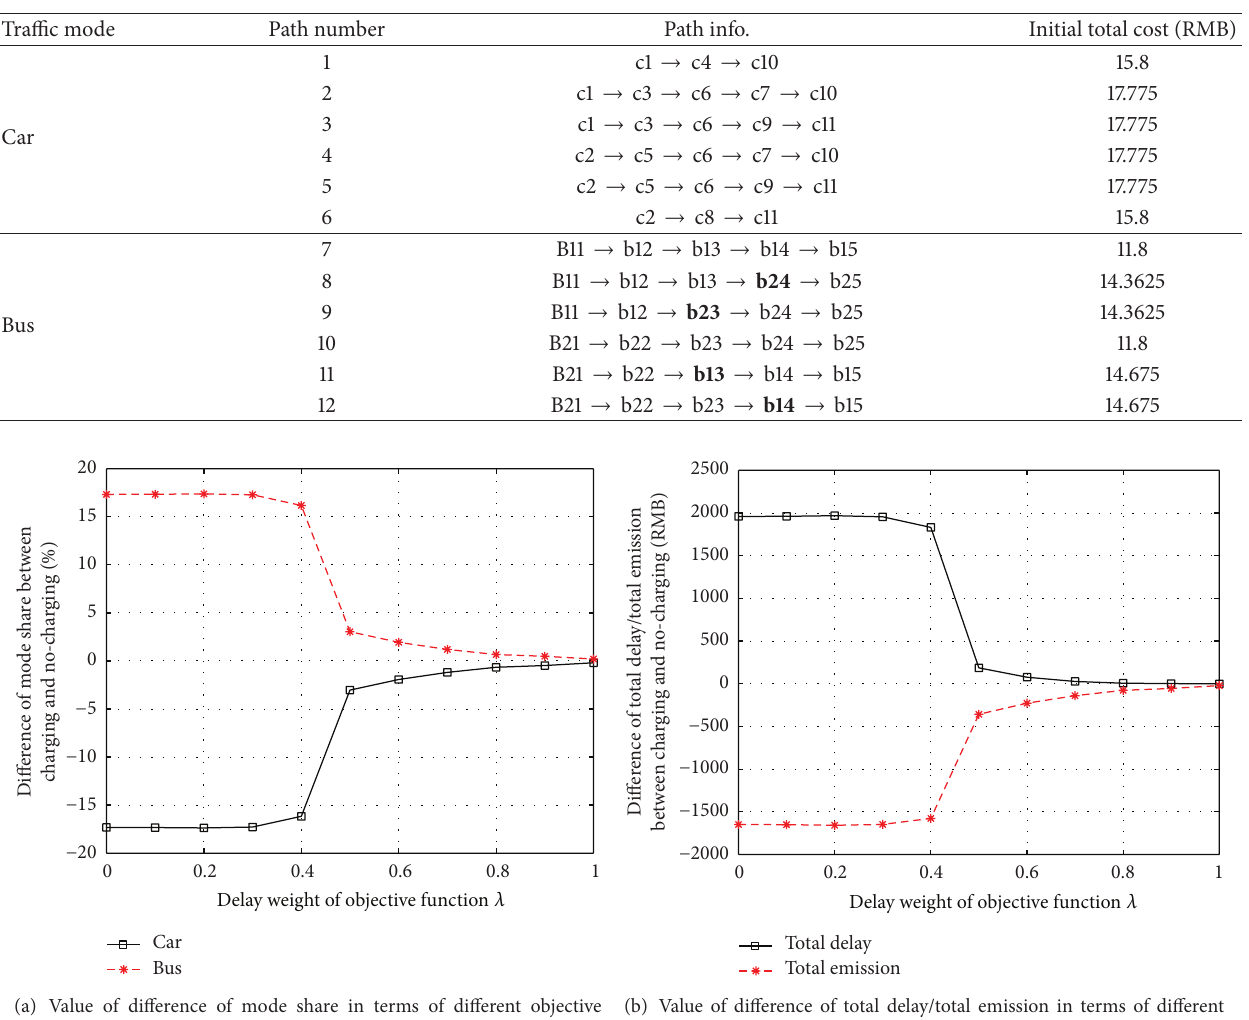
Figure 5: Comparative sensitivity analysis of objective delay weight between pricing and no-pricing.